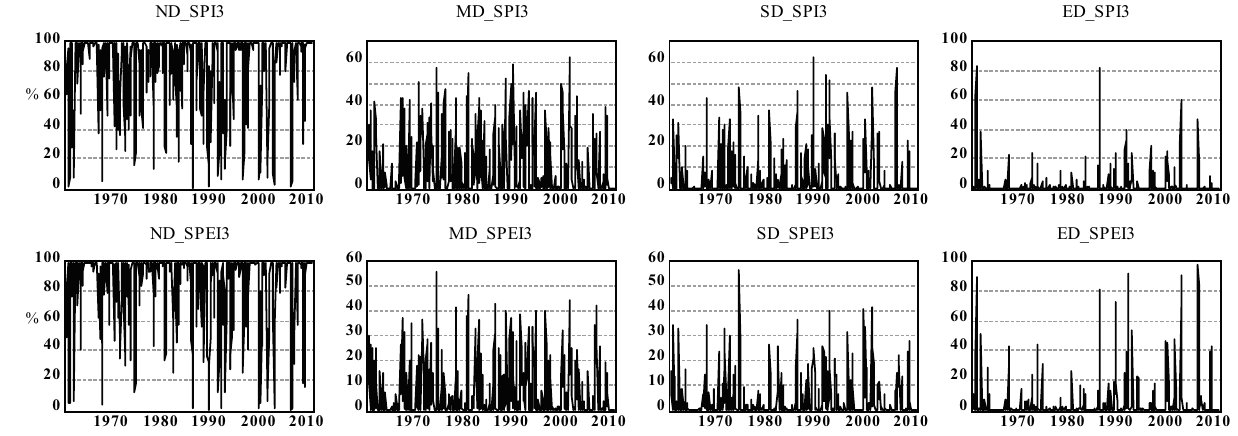
Figure 6. Ω(%) of different agricultural drought (SPI-3 and SPEI-3) categories between 1961 and 2010 across Hungary (figure was generated using EViews (https:// www. eviews. com/ home. html)).